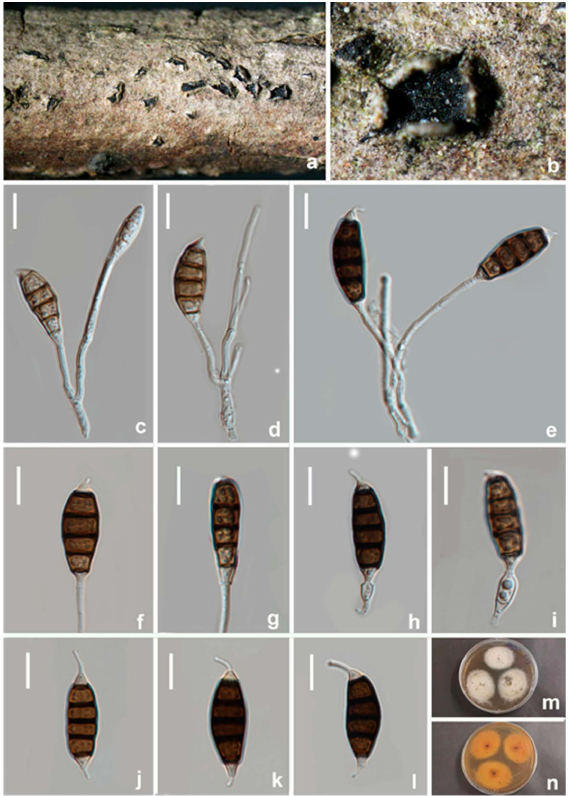
Figure 12. Seiridium ceratosporum (HKAS 123218) ( a , b ) Appearance of conidiomata on host substrate. ( c – e ) Conidiophores and conidia. ( f – i ) Conidiogenous cells and conidia. ( j – l ) Conidia. ( m , n ) Upper and reverse view of the colony on PDA. Scale bars: ( c – l ) = 10 µ